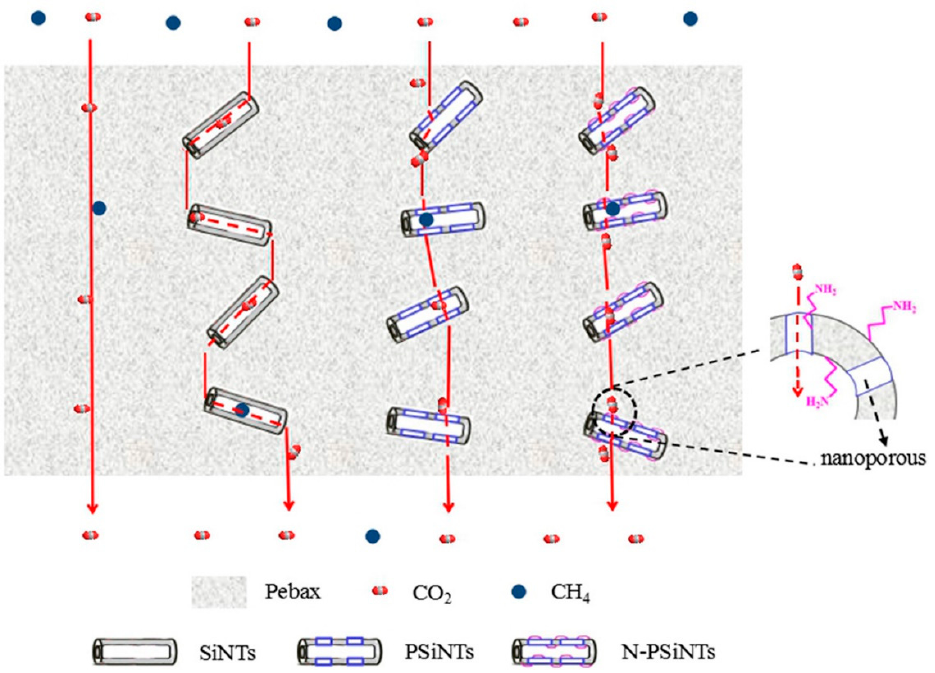
Figure 3. Schematic of the distinct transport modes in MMMs containing non-porous or porous fillers (from ref. [18]).